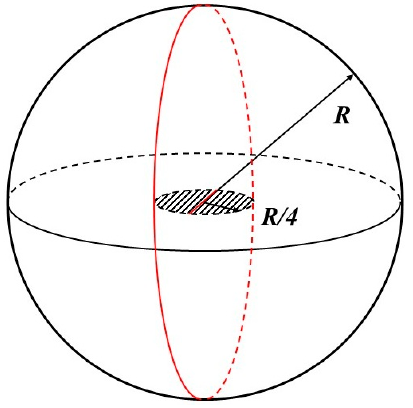
Figure 3. Spherical energy storage particle with a pre-existing penny-shaped crack. Table 1. Geometrical parameters and material properties of energy storage models.